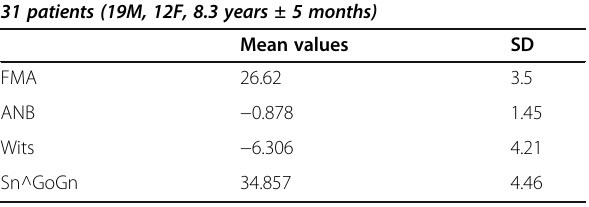
Table 2 Descriptive statistics of the collected sample before treatment